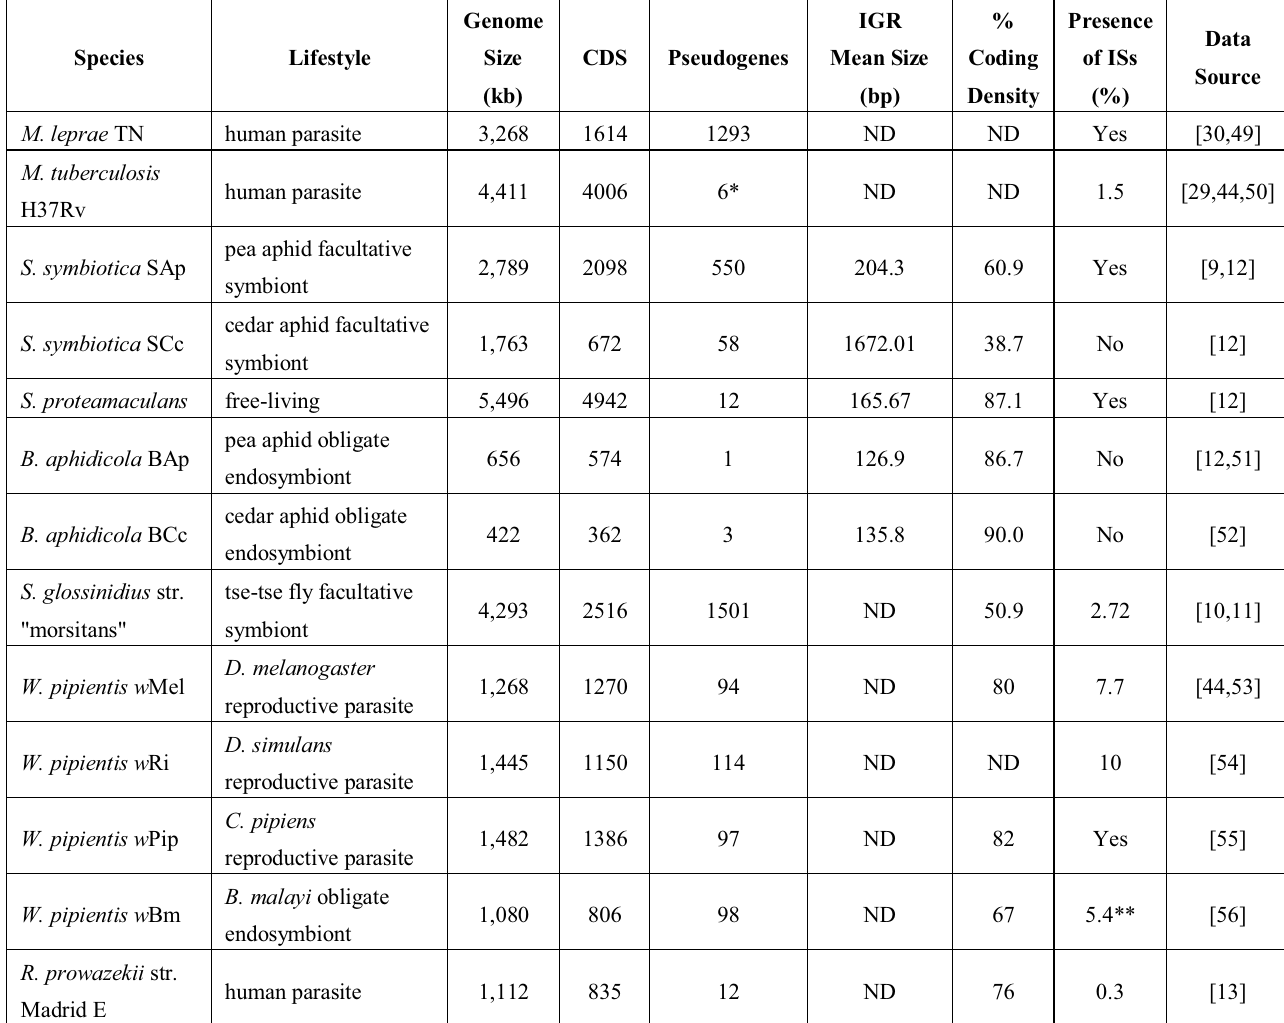
Table 1. Relevant genomic features of selected bacteria with different lifestyles Species Lifestyle